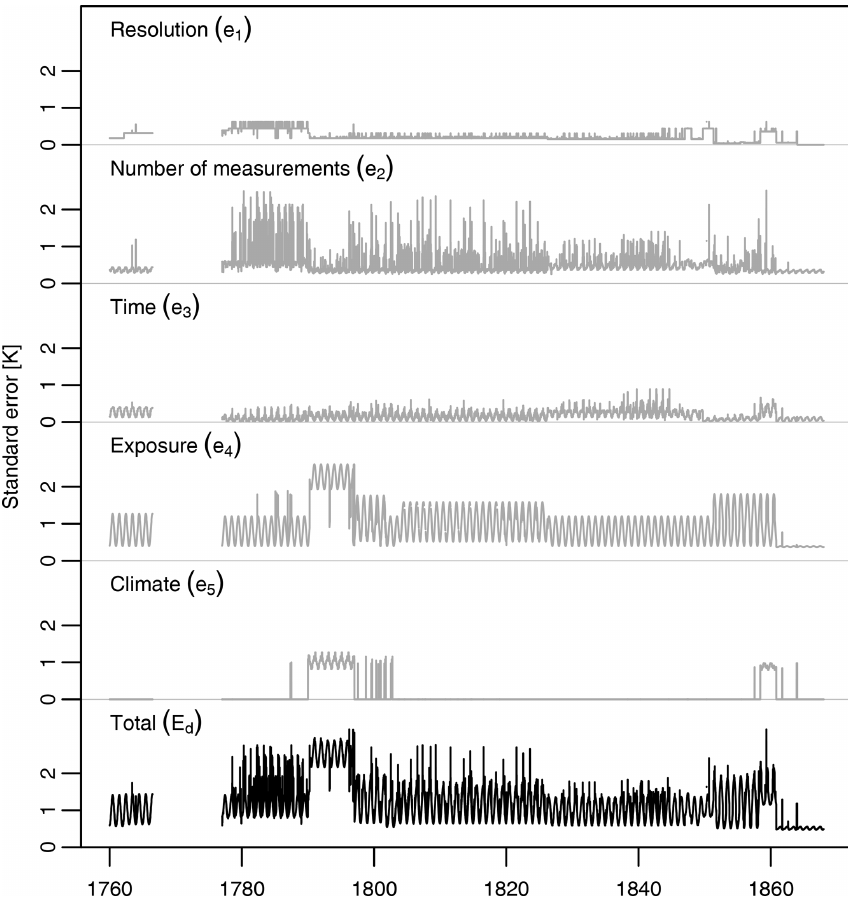
Figure 8. Time evolution of the daily standard error and its components for the merged Bern